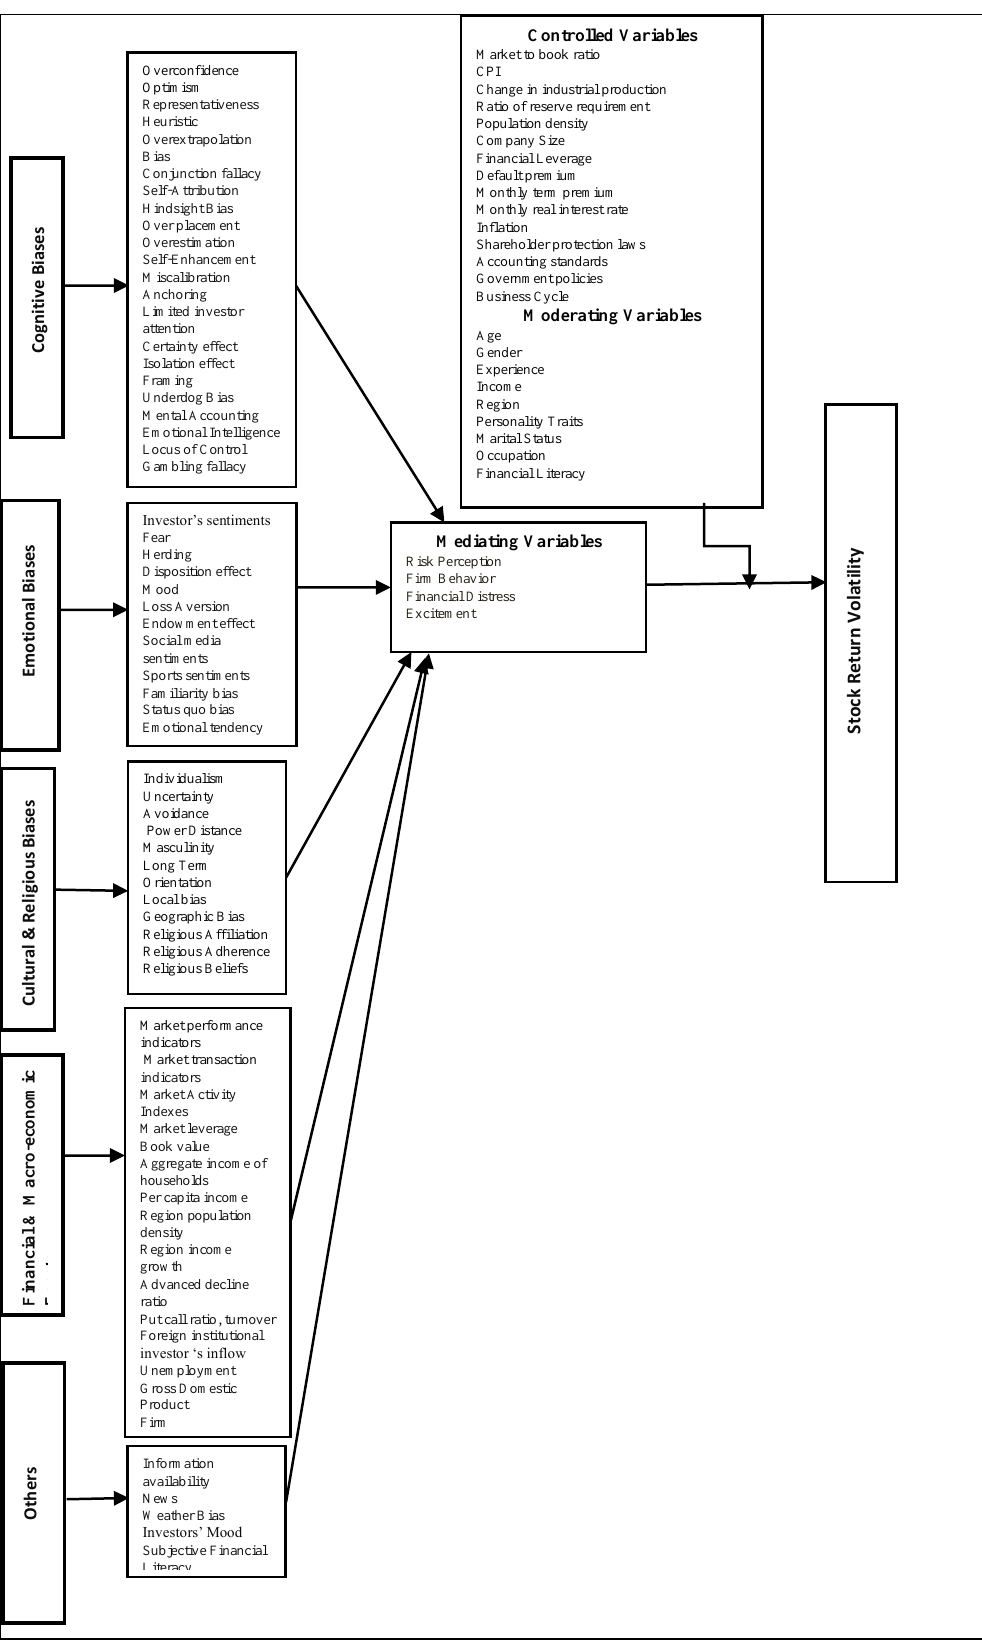
Figure.7. Taxonomy Model of Investors’ Biases & Stock Return Volatility Source: Author’s own